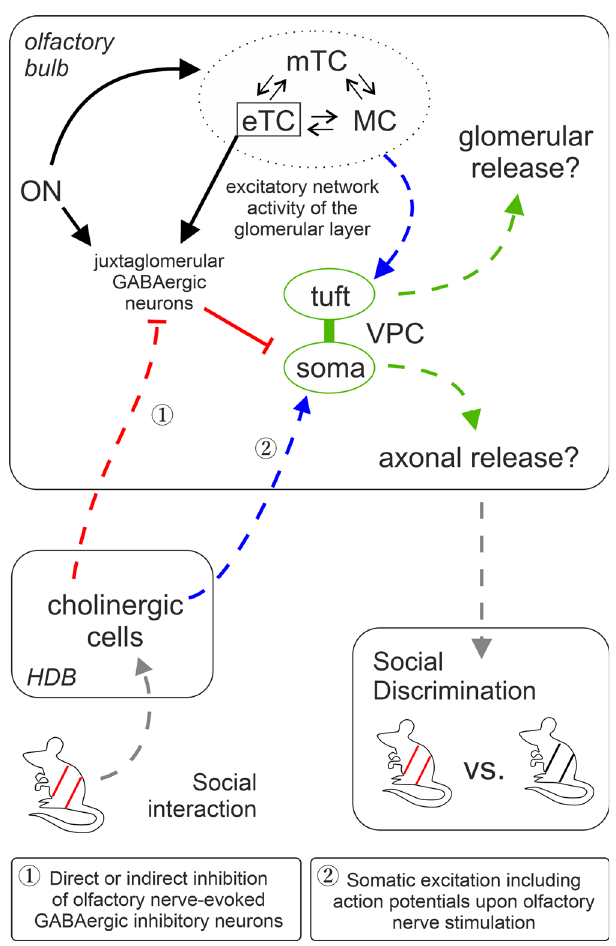
Fig. 7 Graphic summary of OB pathways involved in social discrimination. Blue, green, and gray arrows represent excitatory and red lines inhibitory pathways indicated by this study and our previous publication 8 . The cells within the dashed circle indicate the excitatory network within the same home glomerulus. Dashed pathways were con fi rmed but not fully dissected on the synaptic level. Green pathways are related to vasopressin signaling, gray pathways to sensory input or behavioral output and black pathways are based on fi ndings from literature. Question marks indicate potential dendritic and axonal release of VP in the OB. Axonal projections innervate GL, EPL, MCL, and sGCL. EPL external plexiform layer, eTC external tufted cell, GL glomerular layer, HDB horizontal limb of the diagonal band of broca, MC mitral cell, MCL mitral cell layer, mTC middle tufted cell, ON olfactory nerve, sGCL super fi cial granule cell layer, VPC vasopressin